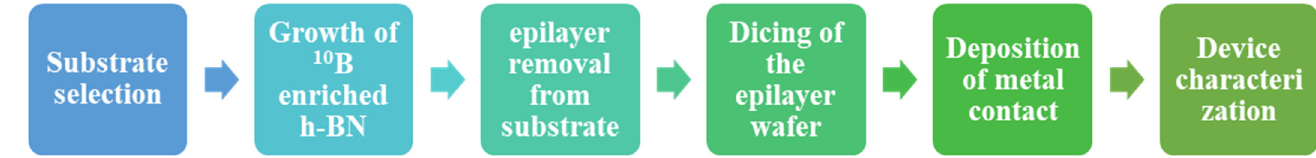
Figure 2. Schematic of h-BN detector fabrication process.